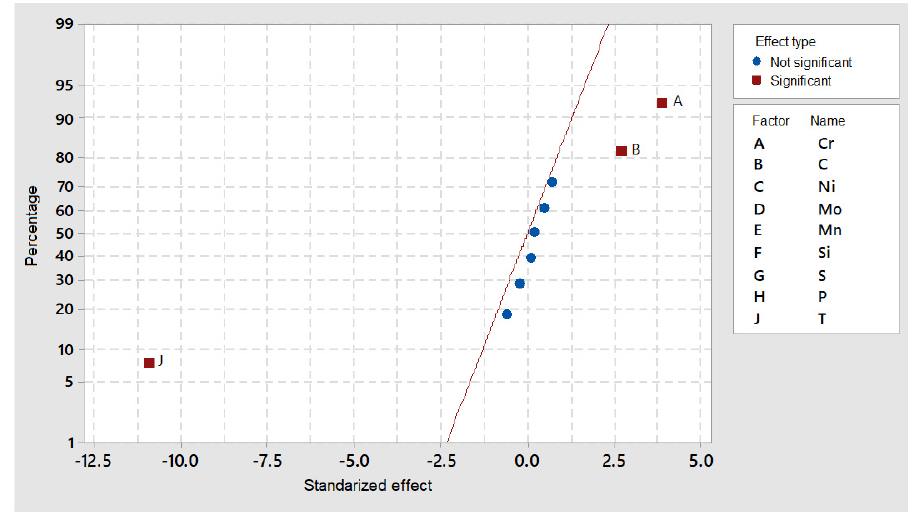
Figure 10. M 7 C 3 precipitates’ nucleation rate (m 3 /s): standardized effects ( α = 0.05) for DOE Thermocalc simulation.